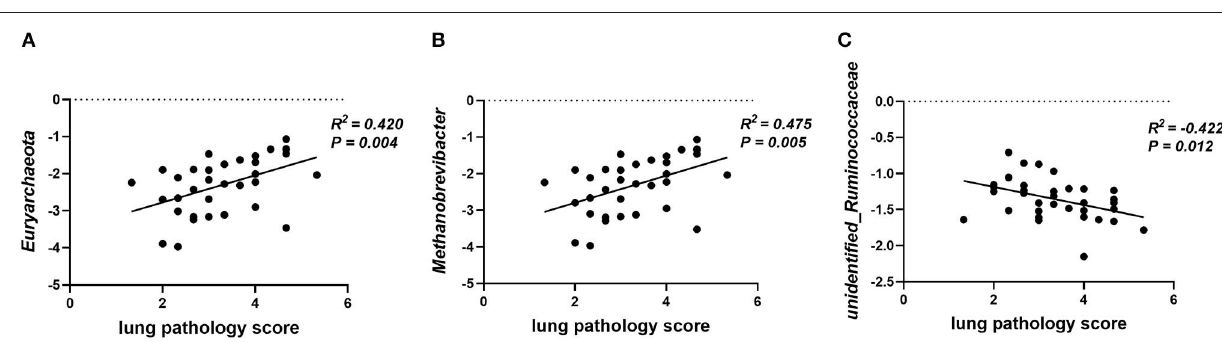
FIGURE 8 | Plot of correlations between lung pathology score and gut microbial abundance at phylum and genus level. The correlation analysis was performed by Pearson correlation tests. (A) Lung pathology score is positively correlated with Euryarchaeota at the phylum level. (B) Lung pathology score is positively correlated with Methanobrevibacter at the genus level. (C) Lung pathology score is negatively correlated with unidentified_Ruminococcaceae at the genus